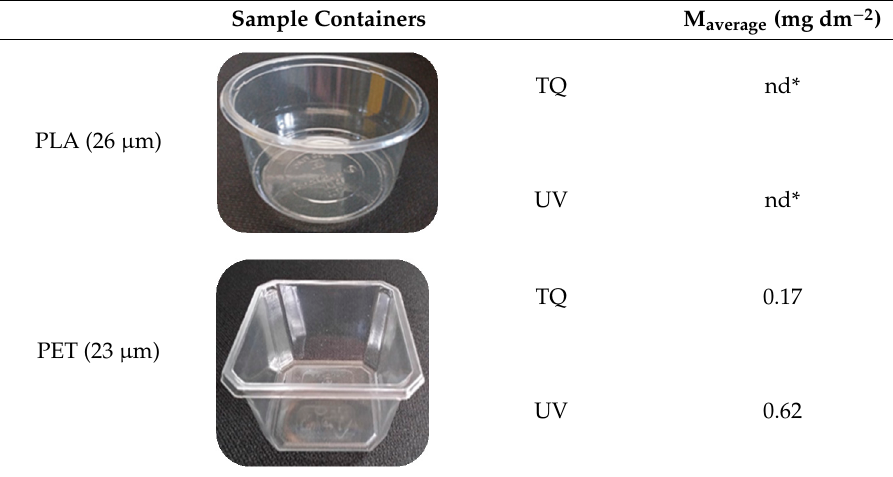
Table 3. Overall migration in acetic acid 3% food simulant from polylactide (PLA) and polyethylene terephtalate (PET) trays, UV treated and not (TQ).